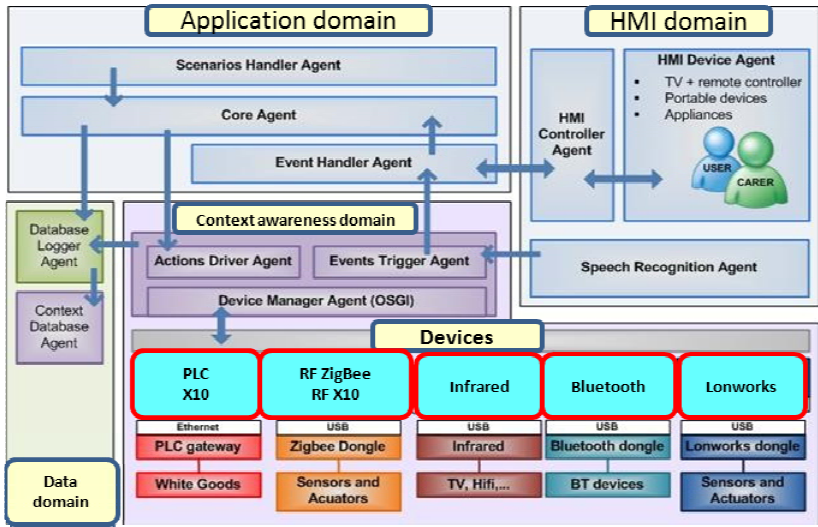
Figure 1. Architecture. Description of technical implementation based on the OSGi architecture. The picture shows different technologies integrated into the system: PLC, Bluetooth, Zigbee ® , Lonworks or Infrared